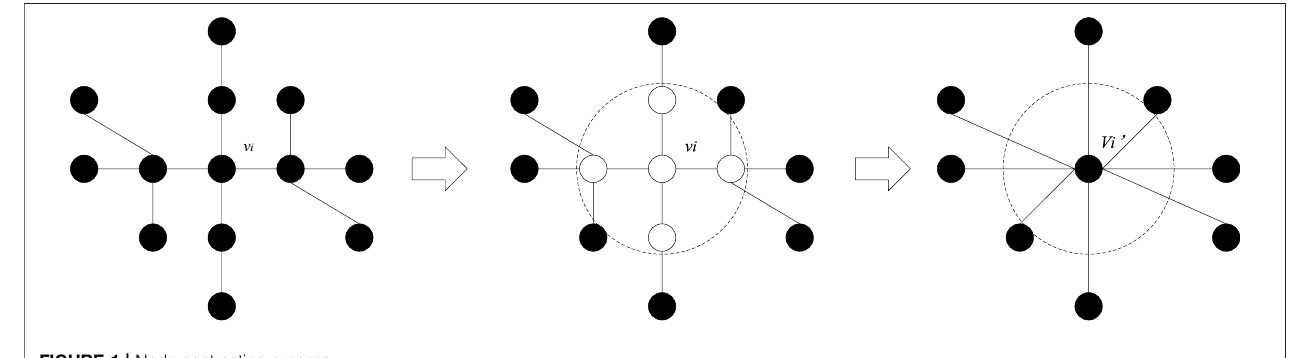
FIGURE 1 | Node contraction